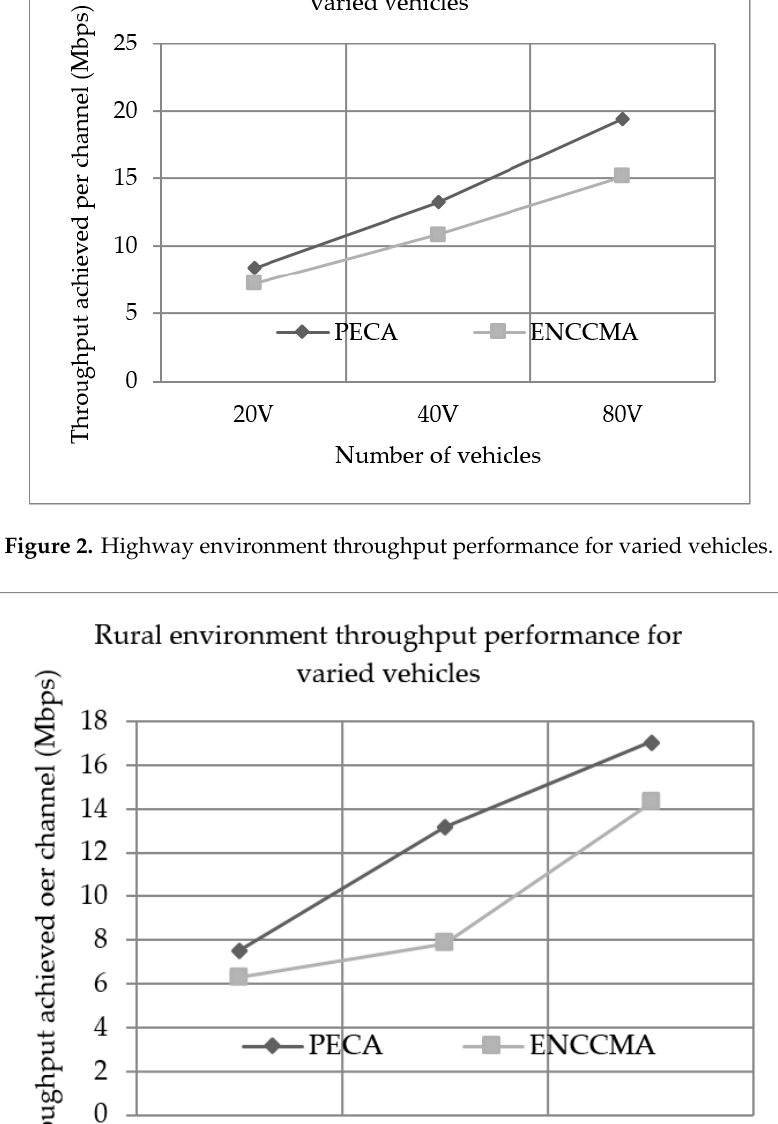
Figure 3. Rural environment throughput performance for varied vehicles.